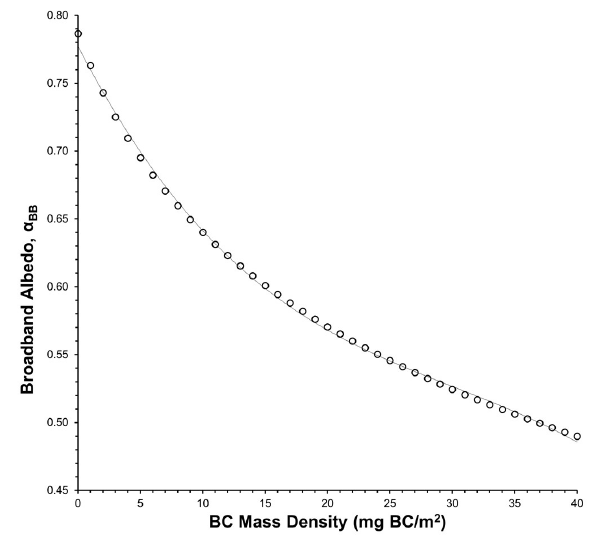
Figure 4. Broadband snow surface albedo α BB calculated with SNICAR (open circles for our standard snowpack) as a function of BC mass density ( BCMD ). The deposited BC aerosol is distributed uniformly in the top 2 cm of our 300 kg / m 3 “standard” snowpack. For example, using Equation (1), BCMD of 40 mg BC / m 2 corresponds to a BC concentration of approximately 6700 ppb distributed in the top 2 cm. The solid line gives a cubic polynomial fit (Equation (2)) in good agreement ( < 1.2% error) with the SNICAR